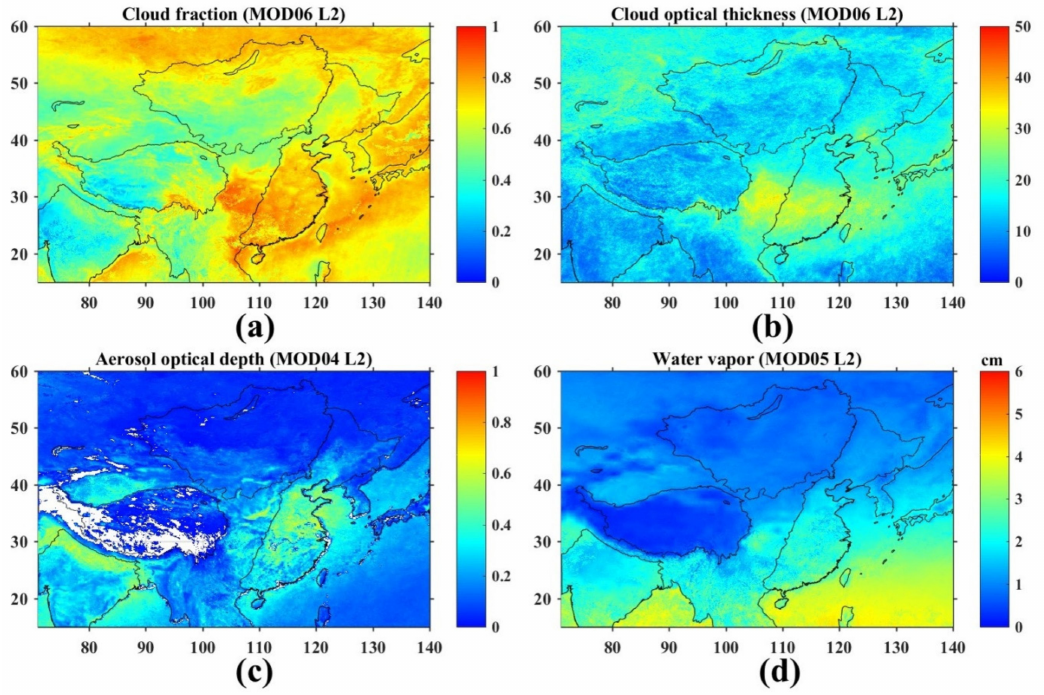
Figure 8. Spatial distribution of atmospheric parameters most relevant to R dif estimation: ( a ) cloud fraction; ( b ) cloud optical thickness; ( c ) aerosol optical depth; ( d ) atmospheric water vapor. We show the averages of monthly results in 2010 of MODIS derived parameters (https: // neo.sci.gsfc.nasa.gov /